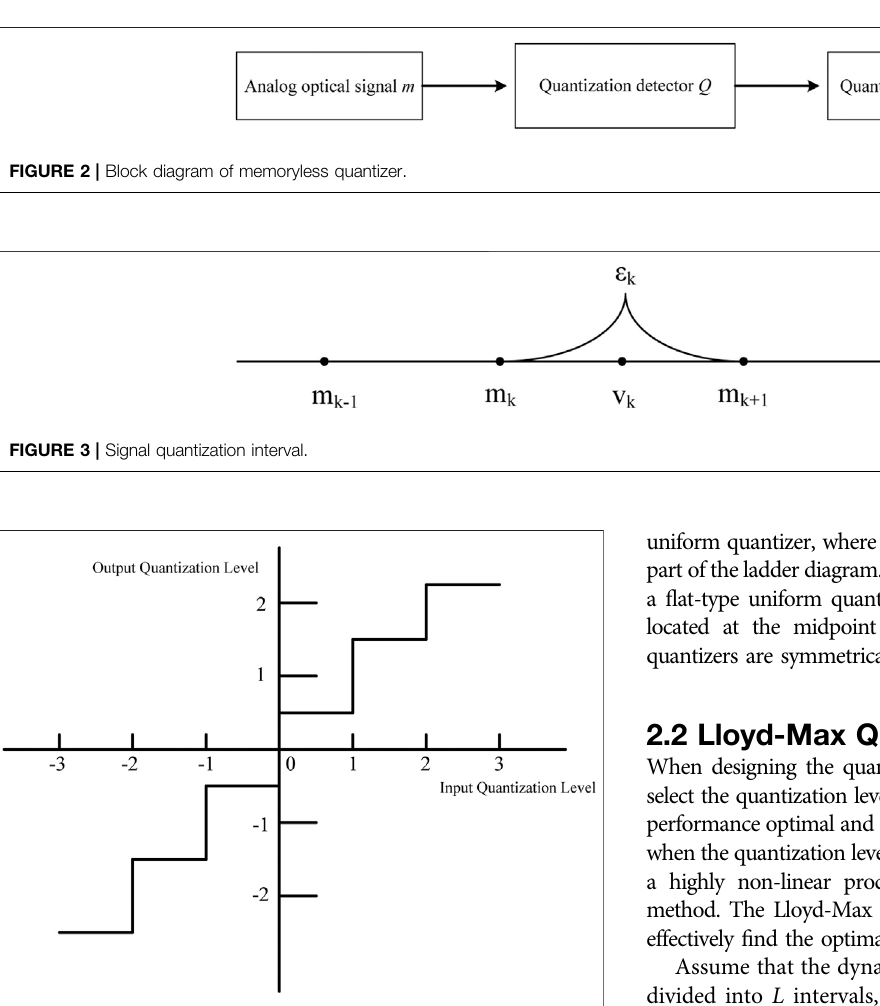
FIGURE 4 | Characteristic curve of medium-lift uniform quantizer.